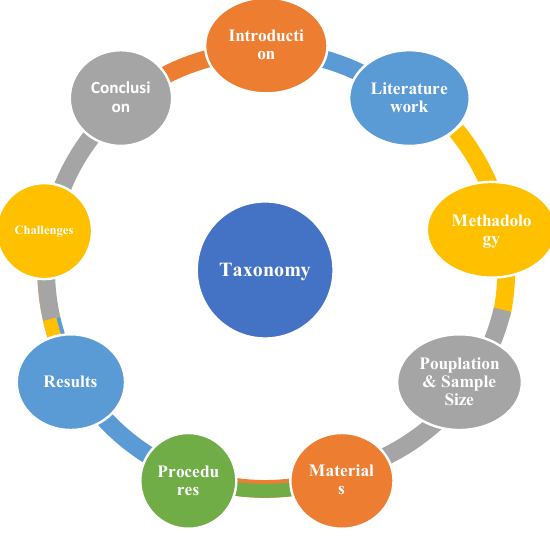
Figure 1. Taxonomy. Figure 1.